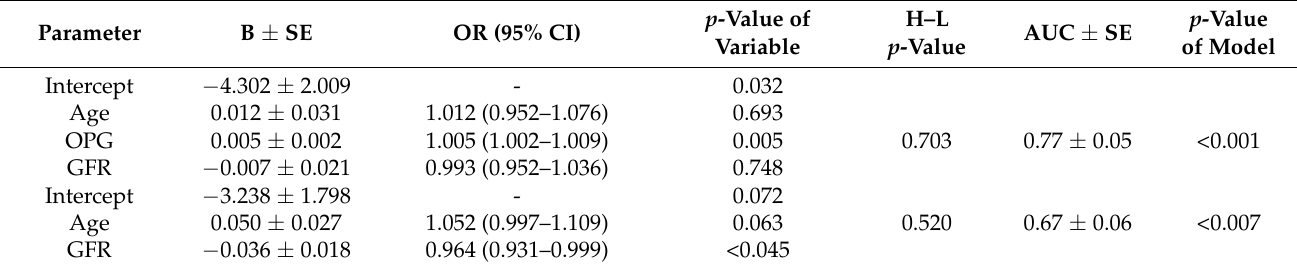
Table 5. Markers associated with inflammation in chronic kidney disease patients based on a logistic regression model.